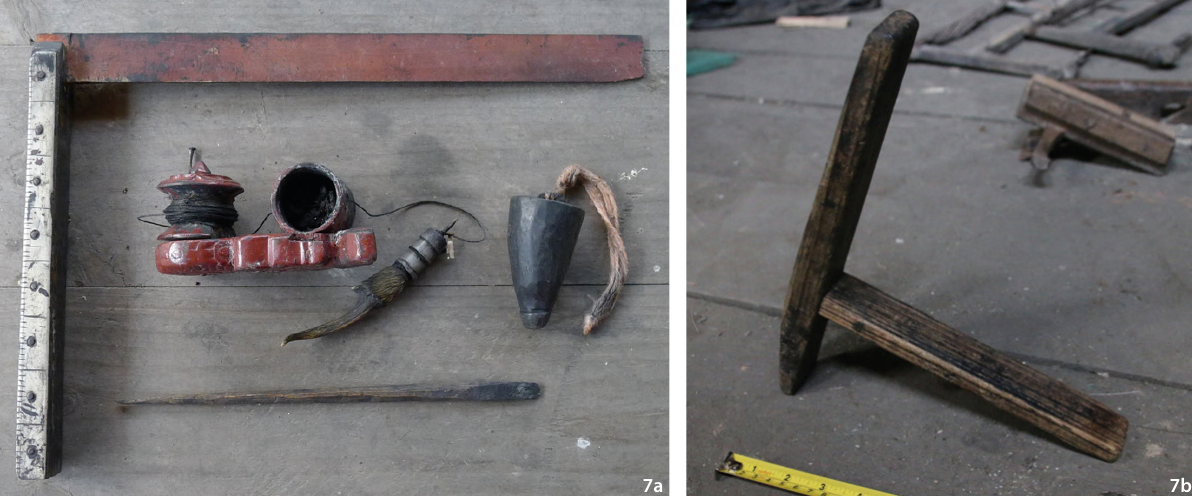
Figure 6 The Taoqian-Jiaoqian technology. (Source: Congcong